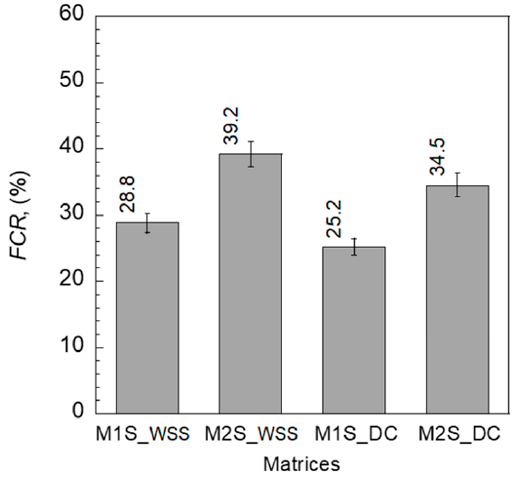
Figure 15. FCR at peak stress of S-UHPCs under compression. The increase in compressive stress of the experimental cubes increased the strain, while the distance between adjacent conductive fillers decreased, and the number of connections of fillers increased. Thus, the contact and tunneling conduction of the composites increased, and the electrical resistivity of the composite consequently decreased [3,21]. Steel fibers affect contact conduction, whereas FSSAs affect tunneling conduction [3,21]. The addition of MWCNTs (nano-electrically conductive material) decreased the distance between FFs at the nano level and further enhanced tunneling conduction under compression. Thus, under compression, the S-UHPCs with MWCNTs resulted in a higher FCR compared to that of S-UHPCs without